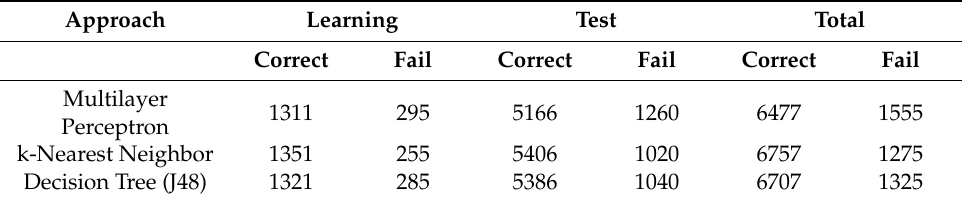
Table 6. Recognizing posture, PO f , of individual in frame.